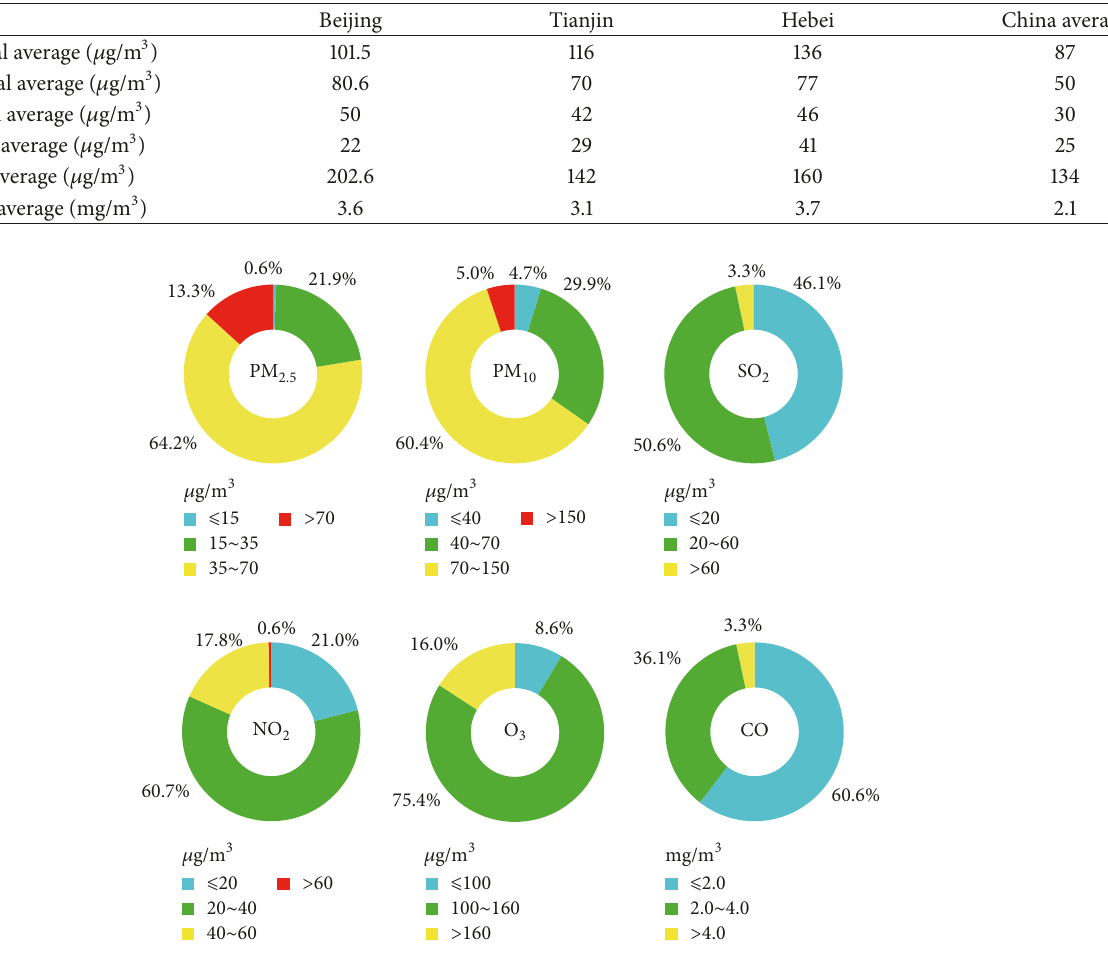
Figure 1: Air quality (or air pollution) variation among 338 monitoring cities in China (source: 2015 State of the China Environment Report